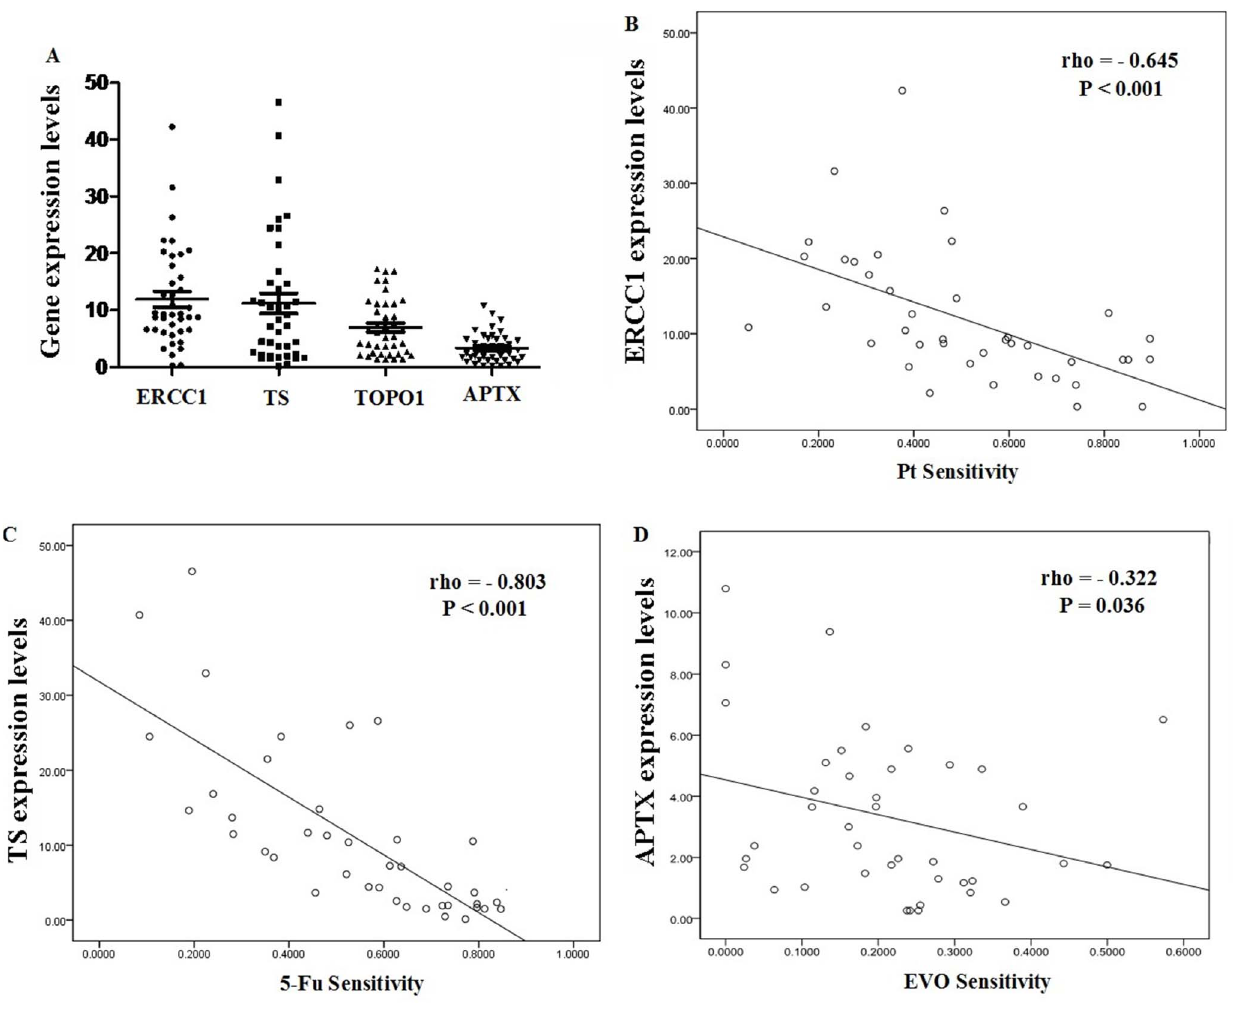
Figure 6. The mRNA expression levels of ERCC1,TS,TOPO1 and APTX, and their correlation with drug sensitivity. A, The mRNA expression levels of ERCC1,TS,TOPO1 and APTX. The lines in the middle stood for mean with SEM; n=40. B, correlation between ERCC1 mRNA expression levels and Pt sensitivity (rho= 2 0.645, P , 0.001, n=40). C, correlation between TS mRNA expression levels and 5-FU sensitivity (rho= 2 0.803, P , 0.001, n=40). D, correlation between APTX mRNA expression levels and EVO sensitivity (rho= 2 0.322, P= 0.036,